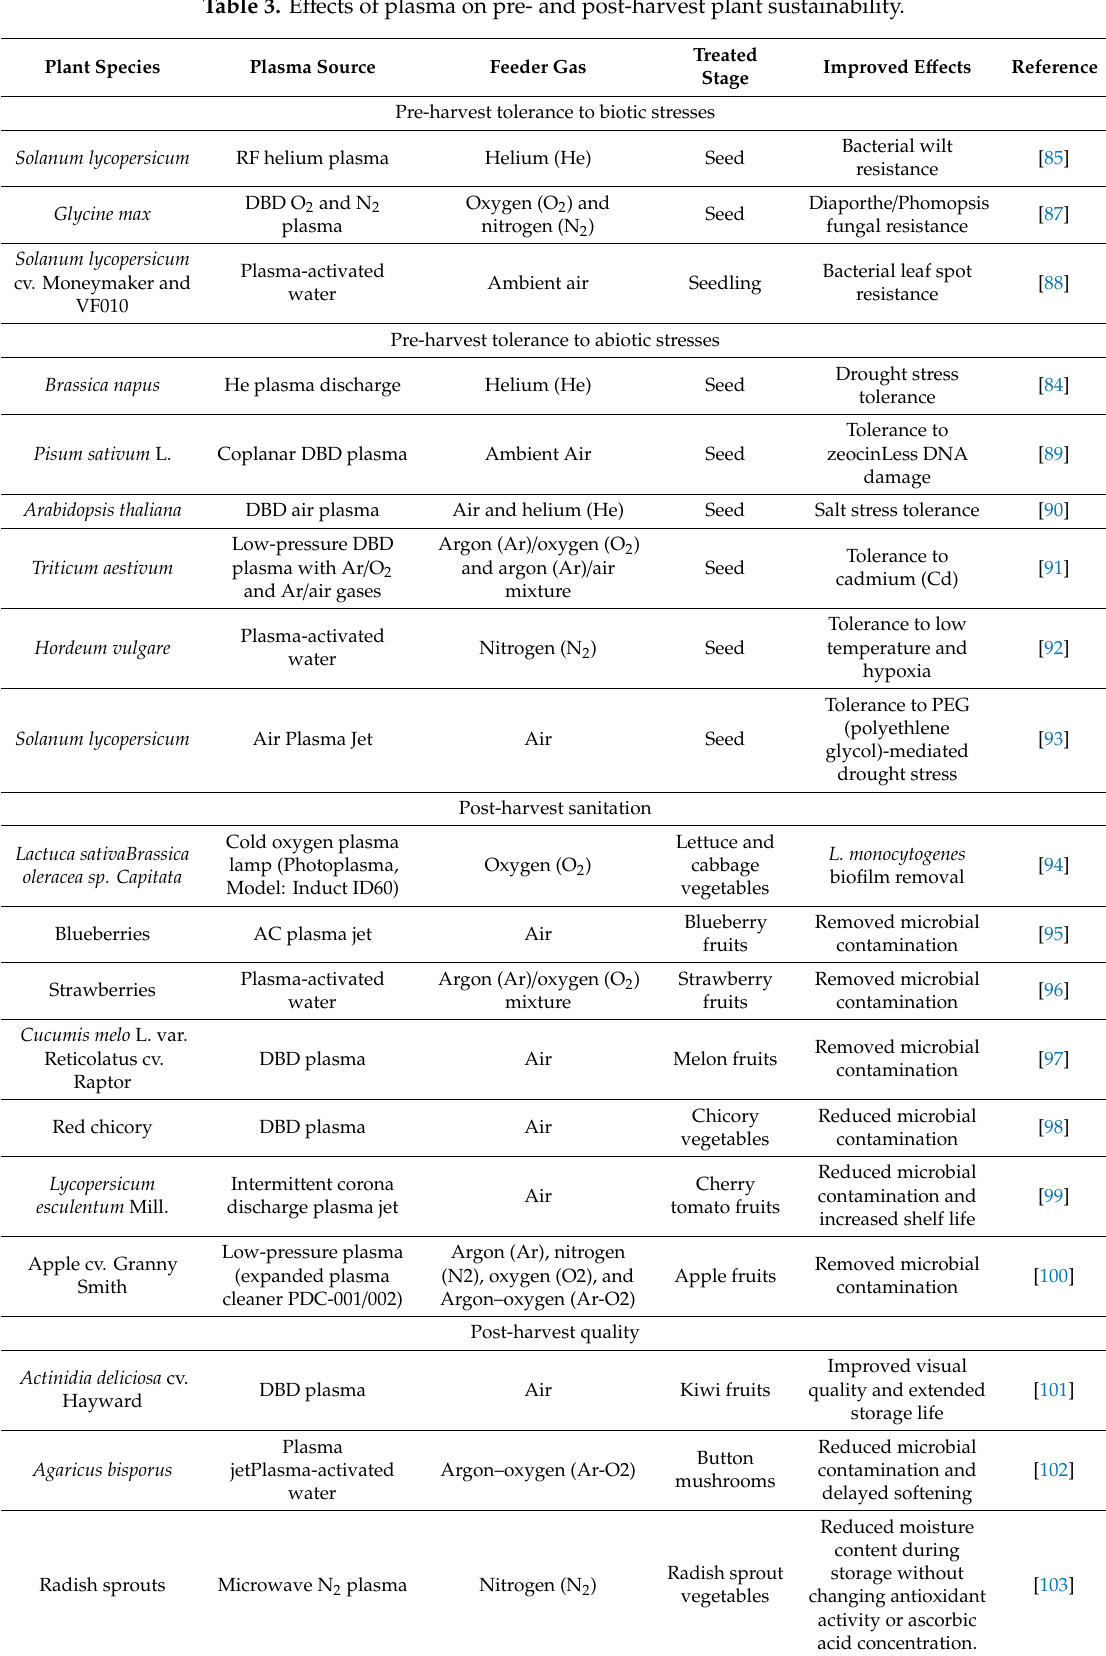
Table 3. E ff ects of plasma on pre- and post-harvest plant